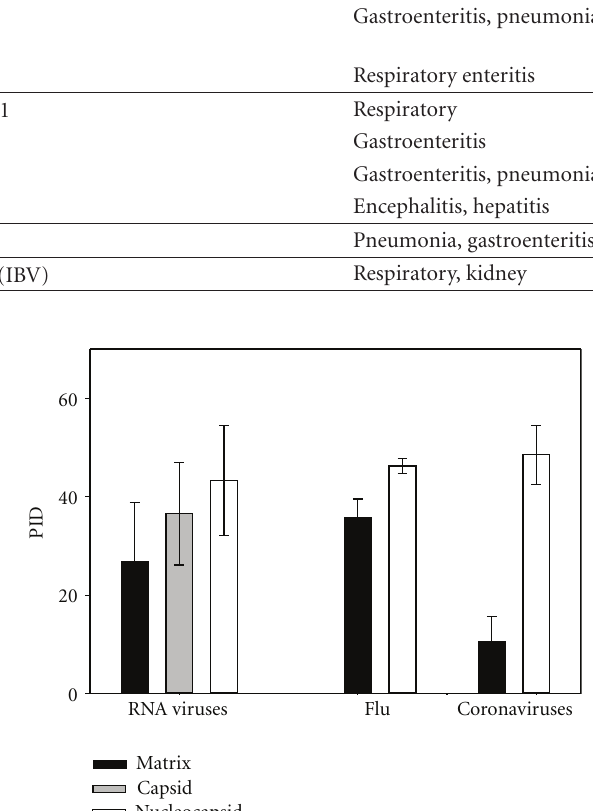
Figure 1: A comparison of the mean PID of membrane (matrix glycoprotein, M) and nucleocapsid (N) proteins of coronavisruses with those of the influenza A virus and RNA viruses in general. Similarities and dissimilarities can be